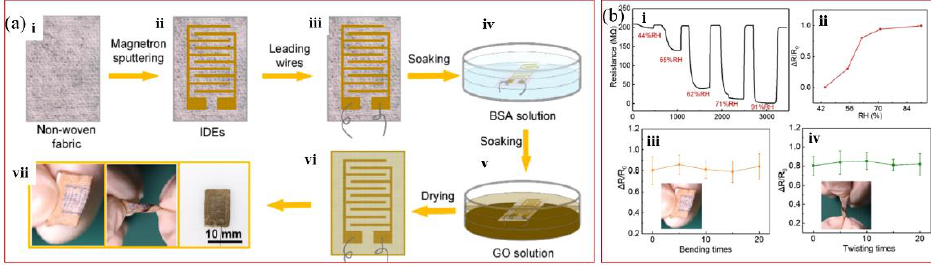
Figure 2. ( a ) Schematic of the humidity sensor fabrication process. ( b ) Humidity sensing performance depending on relative humidity (i,ii) and stability for (iii) bending and (iv) twisting. Reprinted with permission from Reference [28]. Copyright (2020) American Chemical Society.